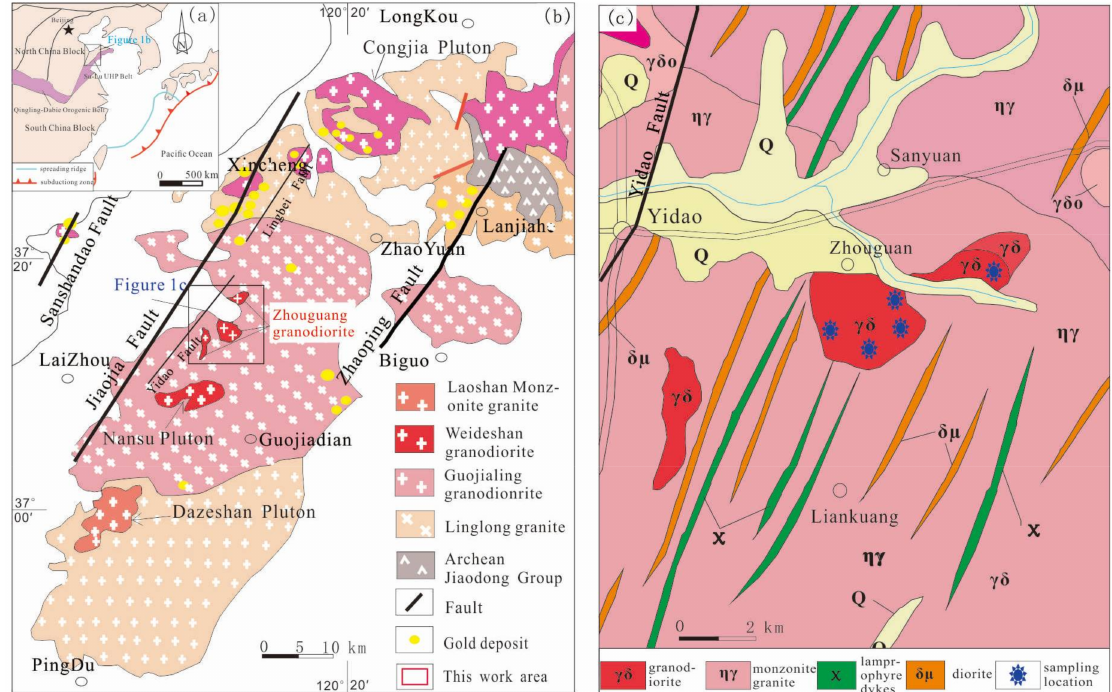
Figure 1. Simplified geologic map of the Jiaodong area. ( a ) The structure outline map, ( b ) The regional geological map of Jiaodong area (modified after Lu et al., 2011 [43]) and ( c ) The study